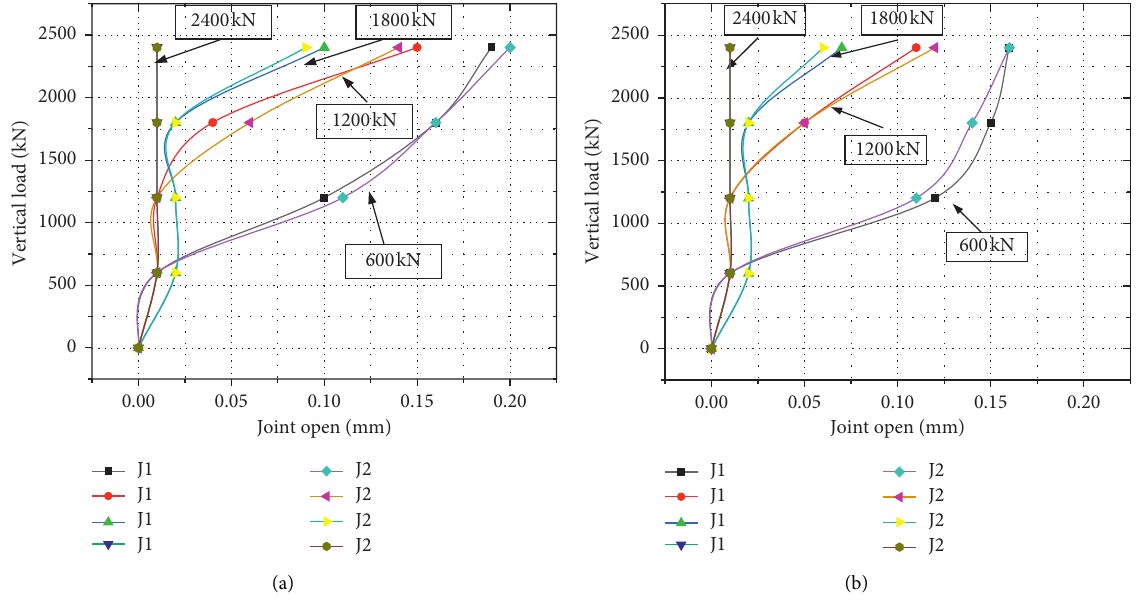
Figure 15: The open amount under different longitudinal forces. (a) Three-tenon type segment. (b) Four-tenon type segment.